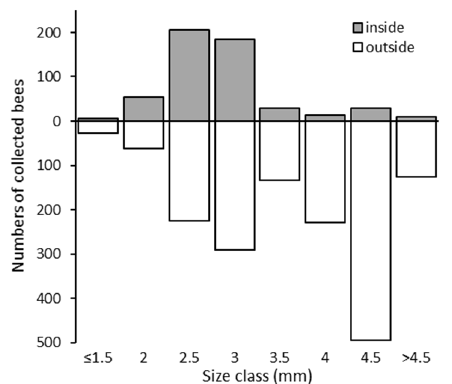
Figure 3. Histogram of the thorax width distribution of bees collected in coloured pan traps placed inside (grey) and outside (white) the netted plot of apple trees during the flowering period in the years 2016–2019. Size classes represent the upper boundary of each class.